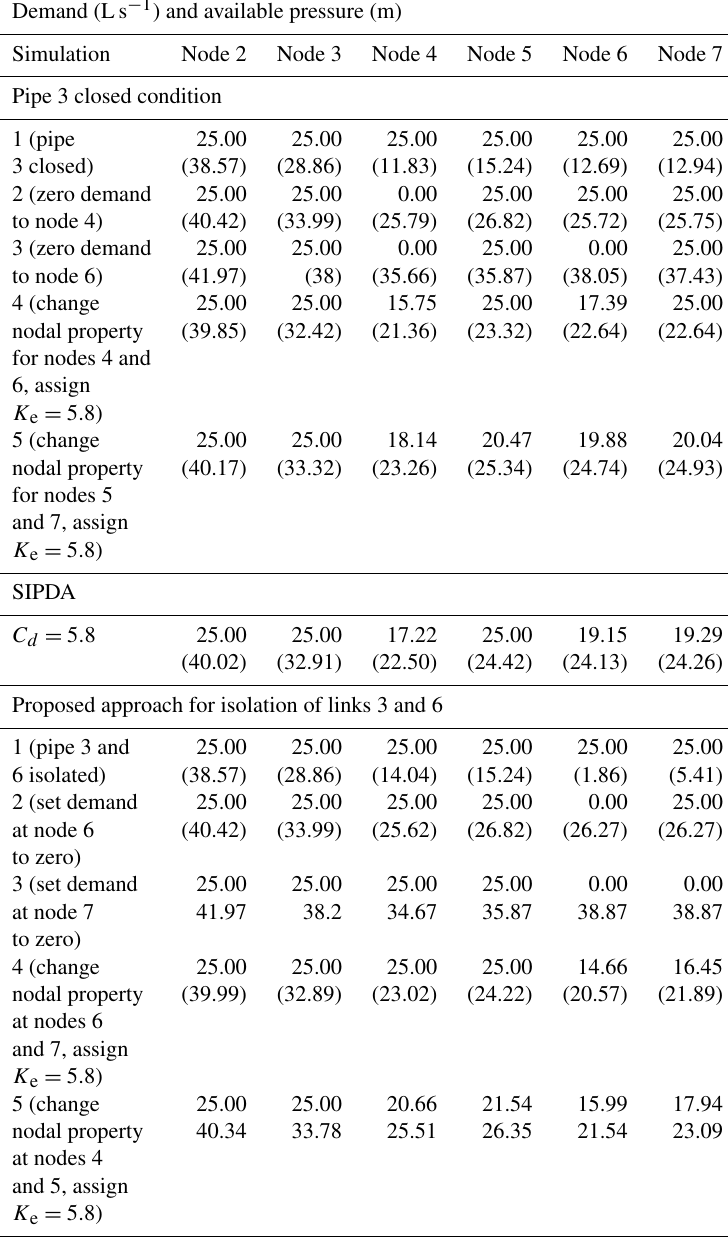
Table 4. Step-by-step analysis results showing nodal outflows under two pressures. Demand (Ls − 1 ) and available pressure